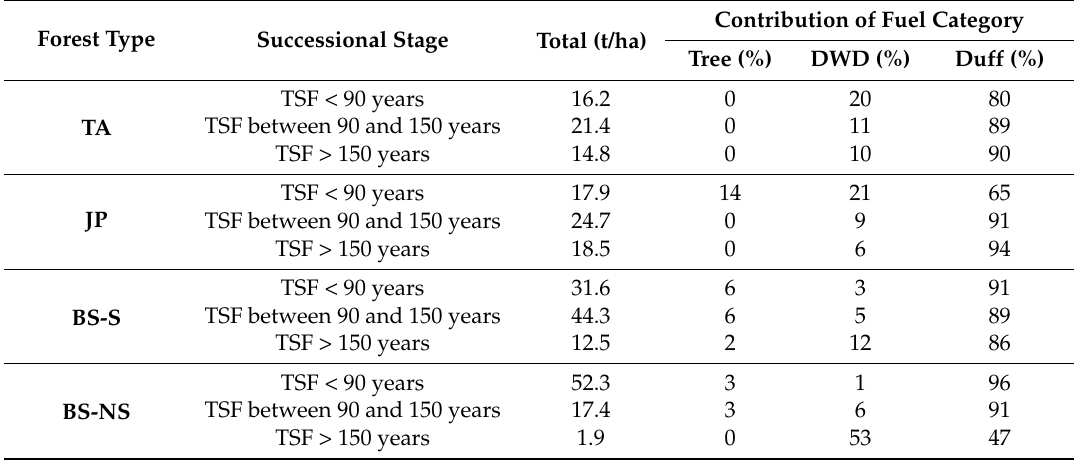
Table 3. Values of total potential carbon emission by forest type and successional stage, and contribution of each fuel category to the total